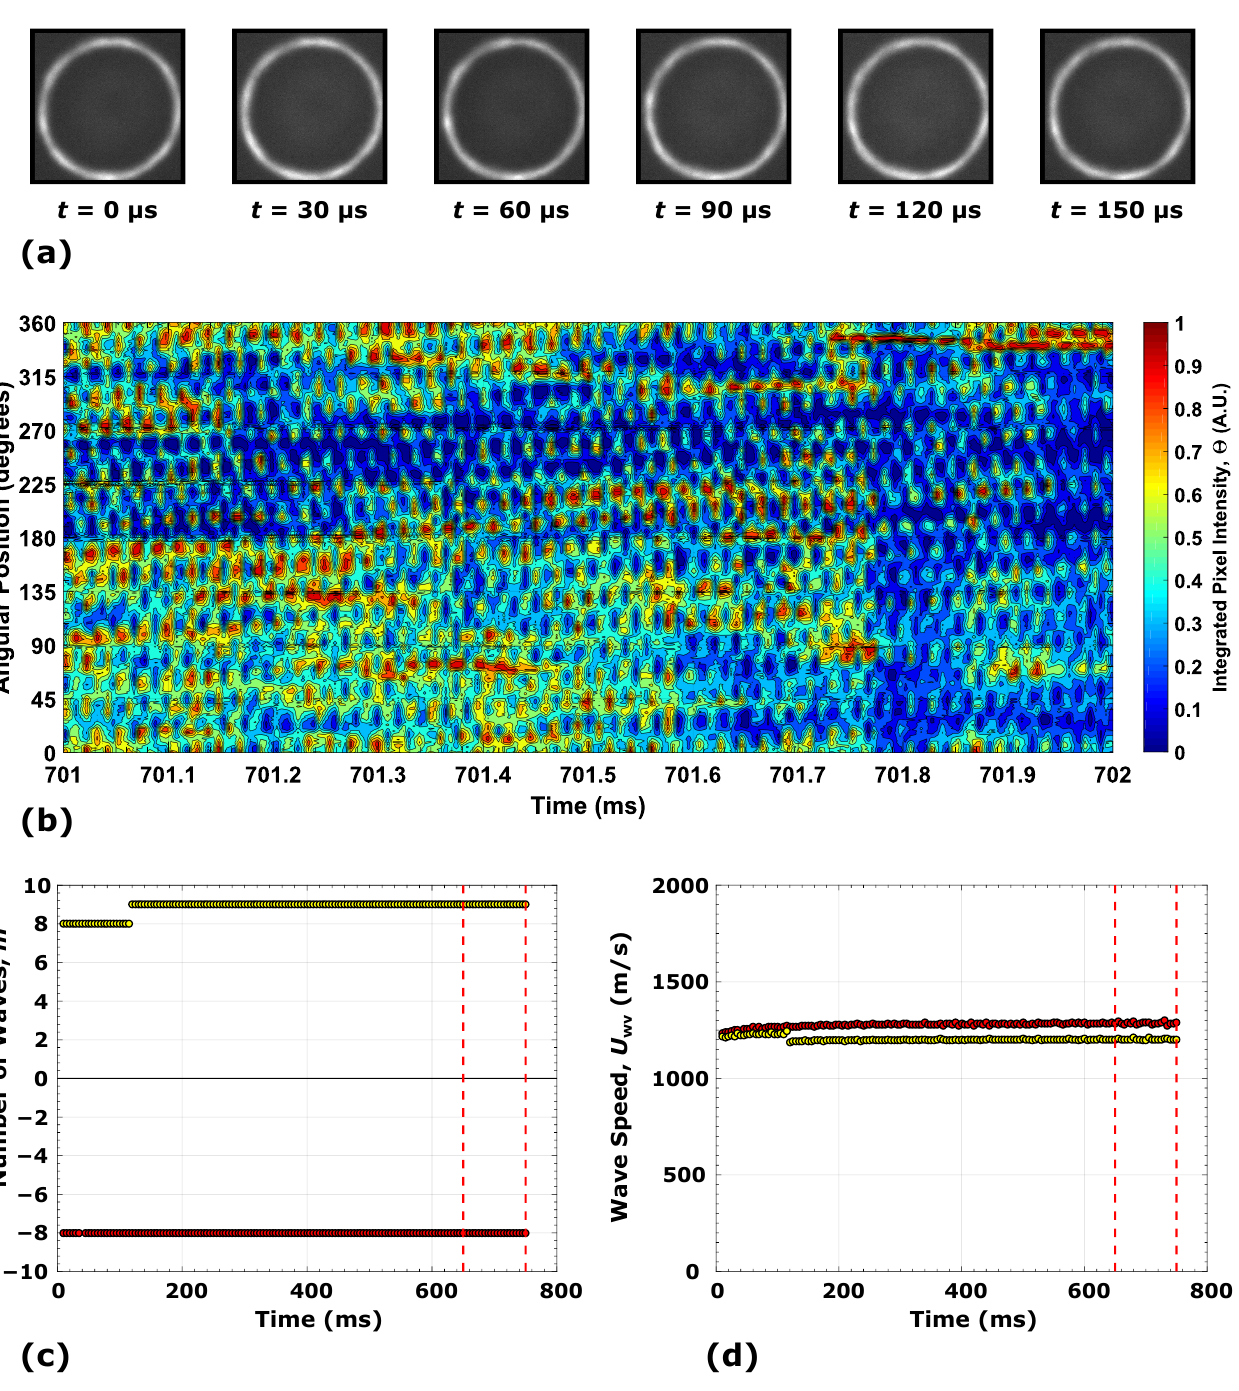
Figure 10. High-speed imaging summary for a counter-propagating mode exhibited with the (cid:101) c = 2.40 nozzle, depicting the ( a ) captured image sequence, ( b ) corresponding detonation surface, as well as the temporal histories of the ( c ) number of waves m and ( d ) average wave speed U wv